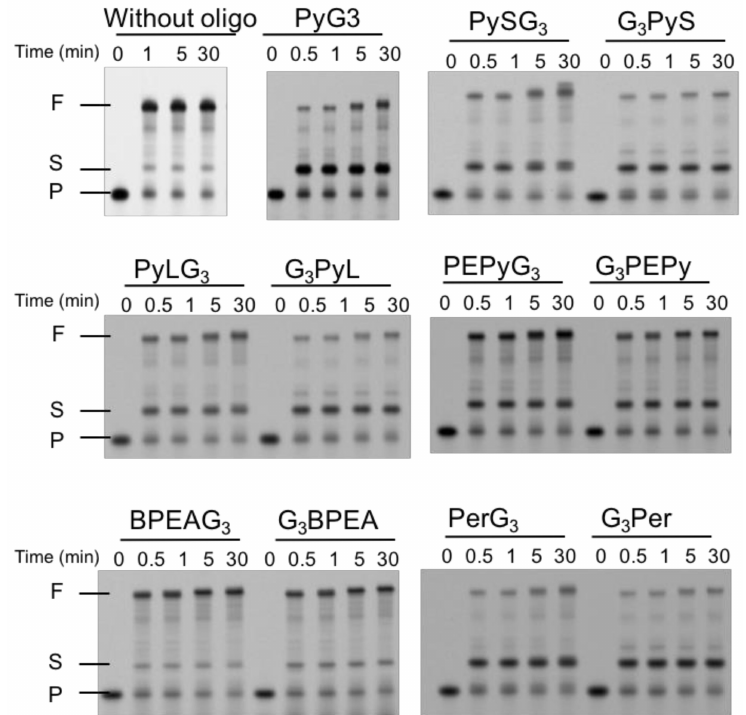
Figure 7. Denaturing-PAGE images of replication products from the VEGF G2T template with each ligand-conjugated guanine tract. All assays were performed in a buffer consisting of 10 mM Tris-HCl (pH 7.5), 8 mM MgCl 2 , and 50 mM KCl with 1 µ M primer, 1 µ M template, 10 µ M ligand-conjugated guanine tract, 250 µ M dNTPs, and 1 µ M KF exo- at 37 ◦